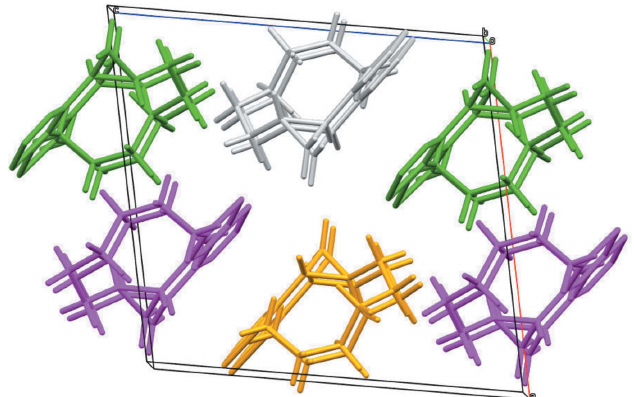
Figure 2 Packing diagram of the title compound viewed along the b -axis direction. Colour key: the asymmetric molecule and its translation clones along [010] grey; molecules generated by twofold screw axes green; molecules generated by inversion symmetry orange; molecules generated by c -glides